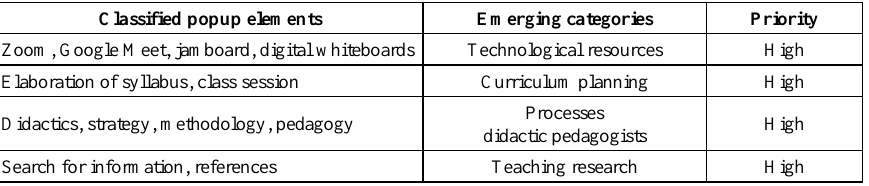
Table 2. Analysis of the responses of the actors listed in Table 1 and